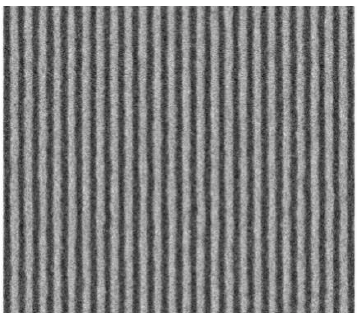
Figure 16. An image of 24 nm pitch lines which are successfully implemented through extreme ultraviolet (EUV) single-patterning process [88].